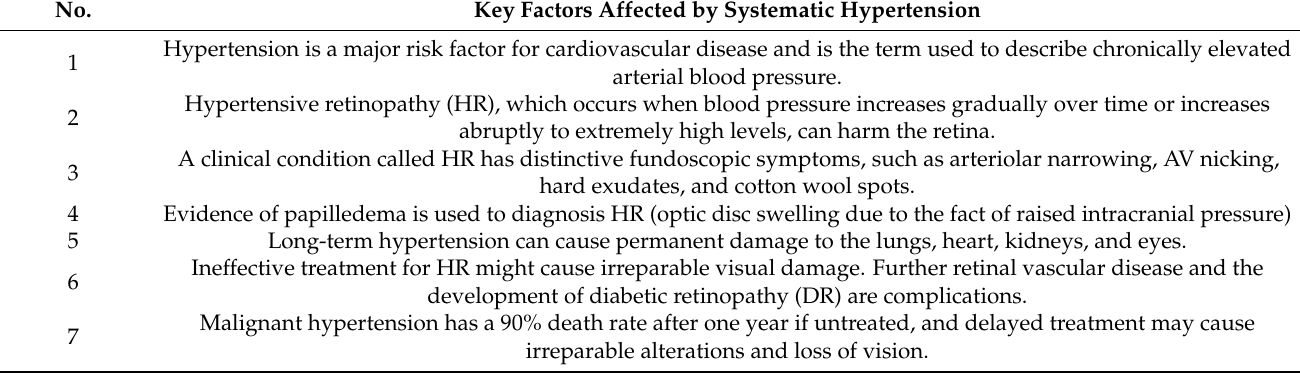
Table 1. Seven key factors affected by systematic hypertension.